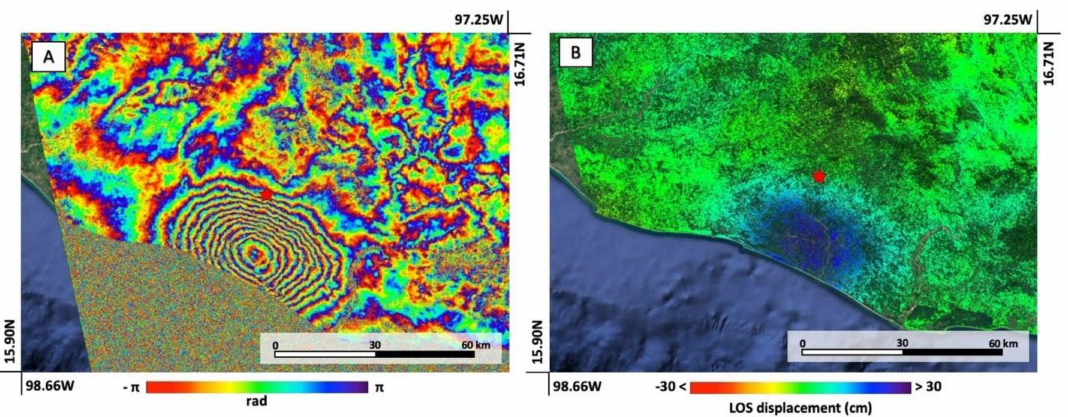
Figure 9. Sentinel-1 results relevant to the 12 February 2018 San Pedro Jicay á n (Oxaca, Mexico) seismic event. ( A ) Coseismic interferogram produced from S1 ascending images (Track 5) spanning the time interval 5 February 2018–17 February 2018. ( B ) Coseismic displacement map related to the interferogram reported in ( A ). The red star identifies the epicenter for the seismic event.